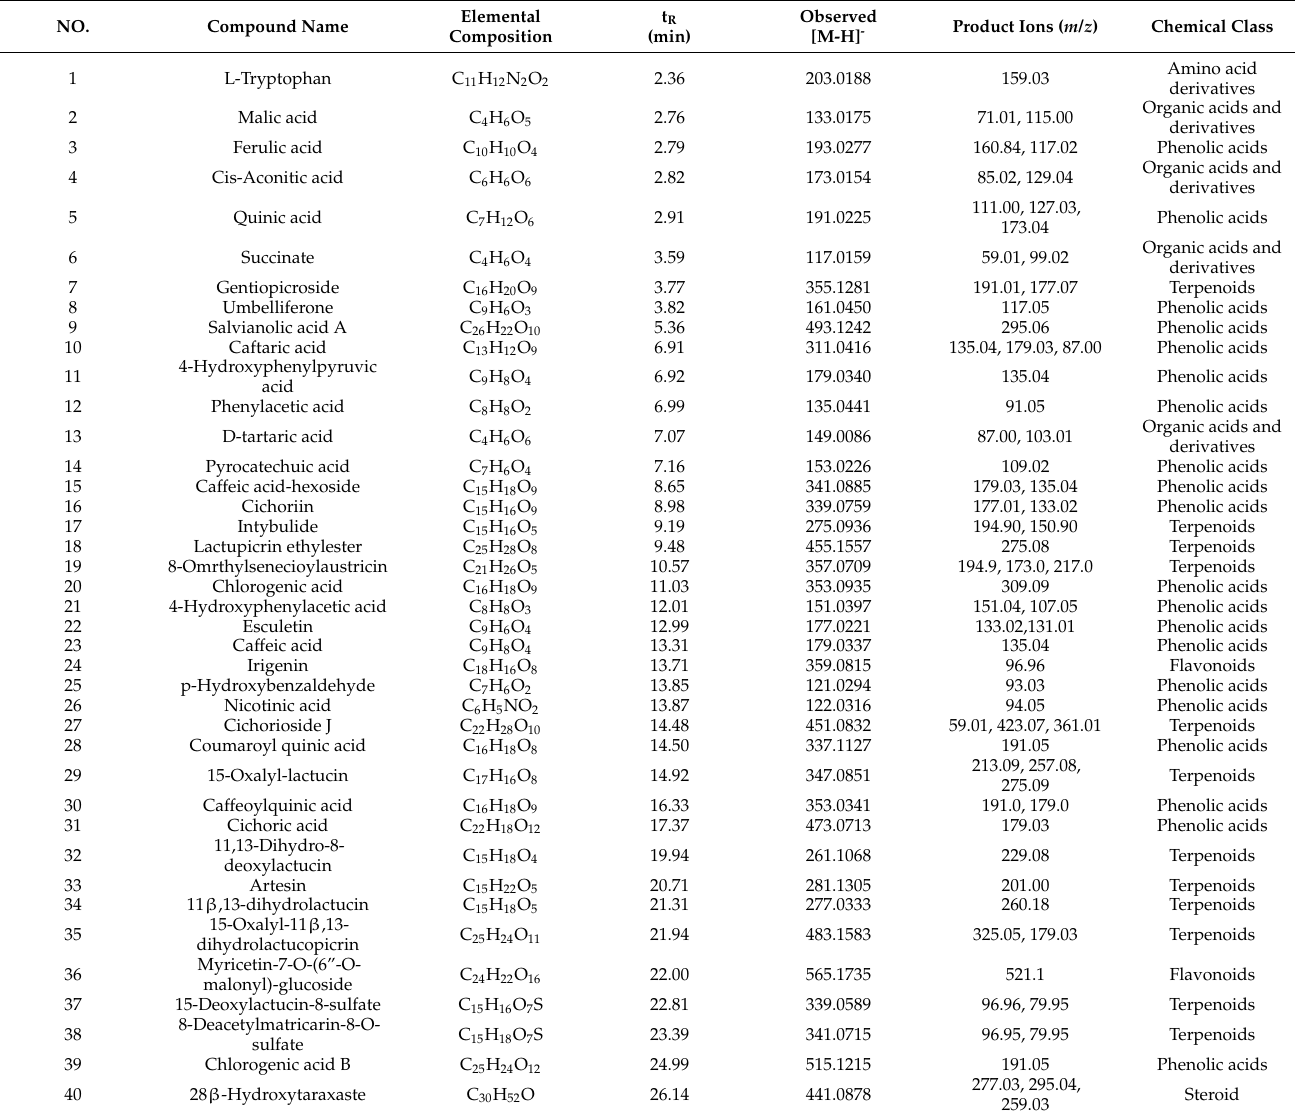
Table 2. Groups of the compounds identified by HPLC-ESI-Q-TOF-MS in CG and